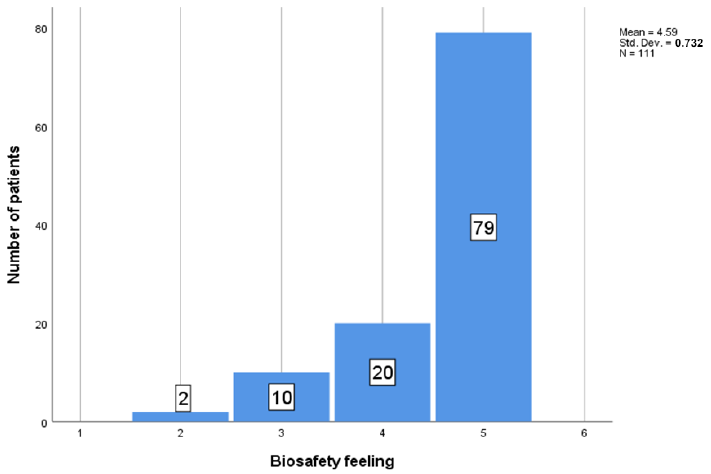
Figure 7. Biosafety feeling records by value.